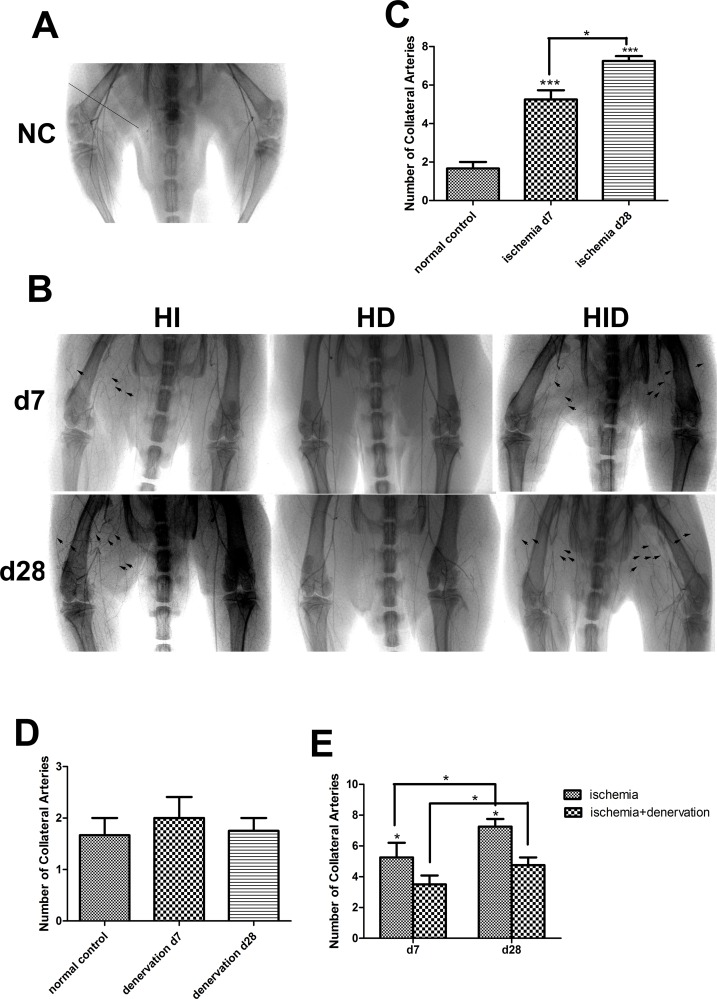
Collateral number shown by X-ray angiograms.The collateral arteries in group NC (A) and HI (right leg), HD (right leg), and HID (right leg: ischemic and denervated, left leg: ischemic) 7 and 28 days post-surgery (B) are shown. The number of collateral arteries was obtained by counting the arteries that intersected a line that was perpendicular to the midpoint of the femur (shown as a straight line in A). The remodeling collateral arteries are indicated with black arrows. Few pre-existing collaterals was seen in group NC (A). The number of collaterals in group HI significantly increased compared with group NC on day 7 and further increased on day 28 post-surgery (C). The number of collaterals did not change 7 or 28 days post-surgery in group HD (D) compared with group NC. In group HID, the number of collaterals (the right leg) also increased compared with group NC, but the number was lower than group HI on day 7 and 28 post-surgery (E). n = 4 per group * p<0.05, *** p<0.001.